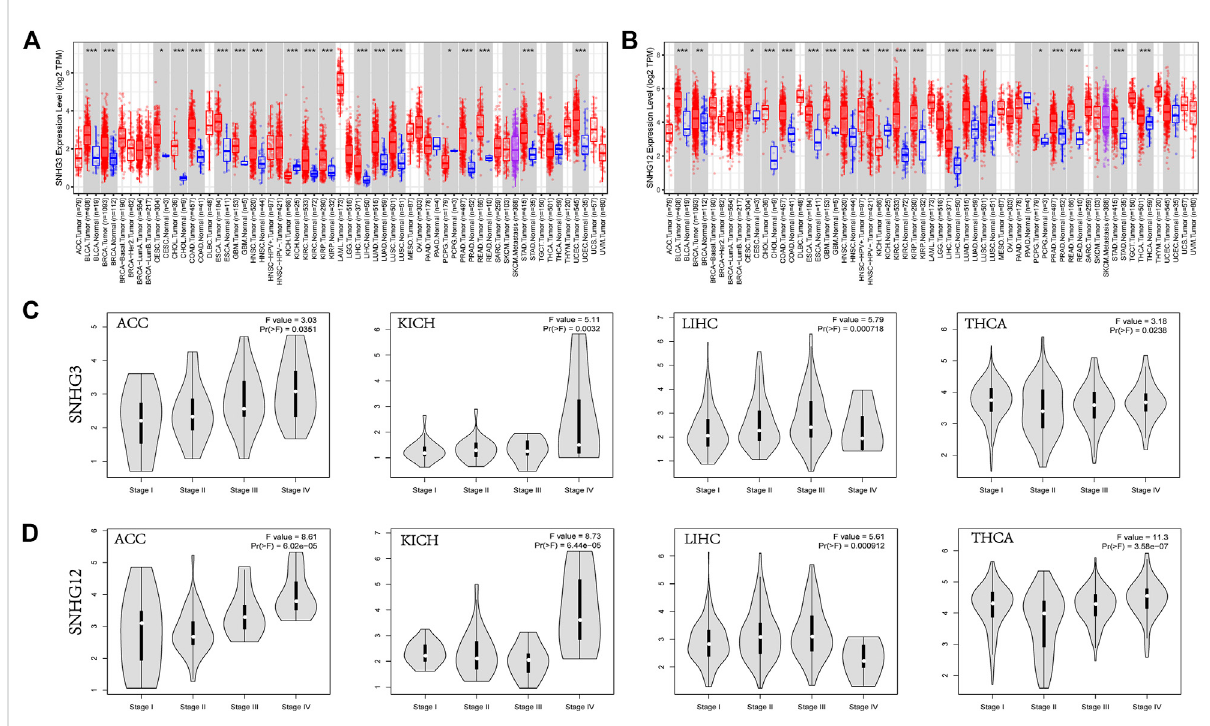
SNHG3/SNHG12 expression in pan-cancer. (A,B) SNHG3 and SNHG12 expression in pan-cancer. (C,D) Differential expression of SNHG3 and SNHG12 in different stages in ACC/KICH/LIHC/THCA. * p < 0.05; ** p < 0.01; *** p <